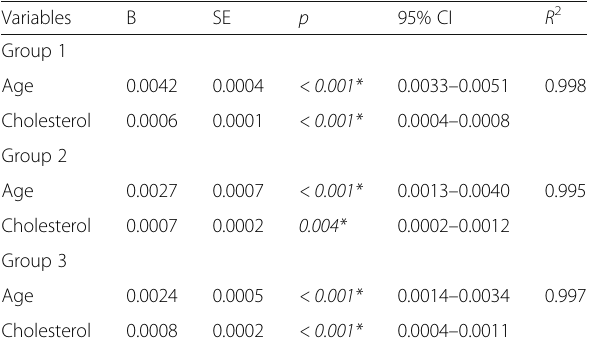
Table 4 Linear logistic models for factors affecting RRI among the studied groups Variables